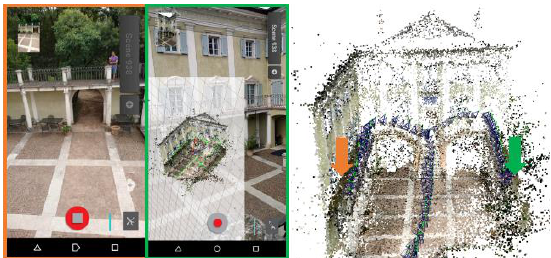
Figure 2: Example of on-the-fly visual feedback inside the smartphone’s app (left) during a collaborative digitization process (here two users involved) or on the web browser (right).